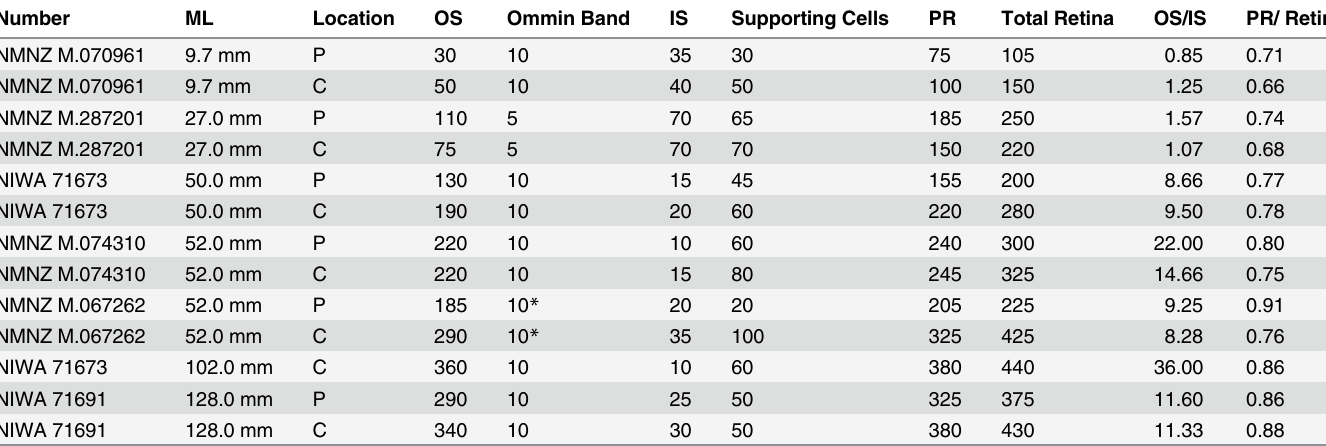
Table 1. Measurements of visible retinal layers in the ventral retina of Teuthowenia pellucida